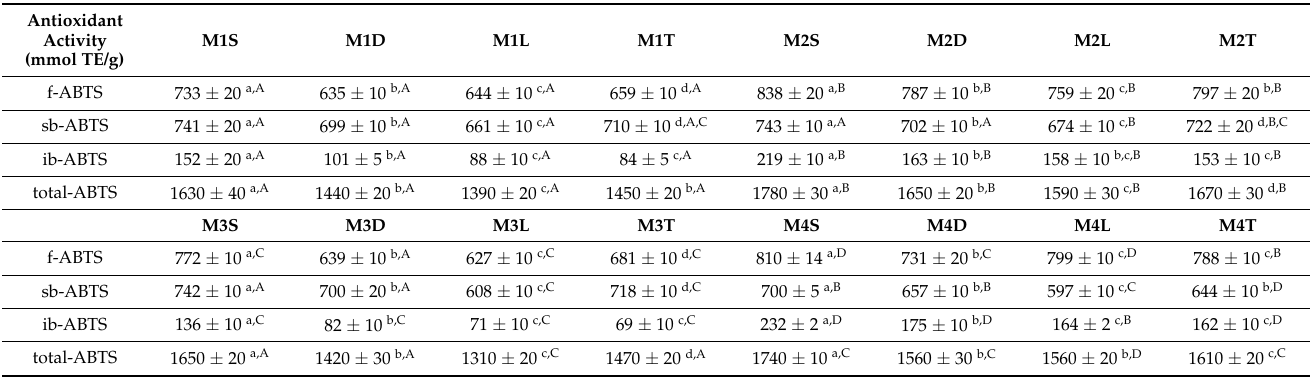
Table 5. Antioxidant activity values of nutraceutical mixtures under the defined storage conditions measured using ABTS radicals.